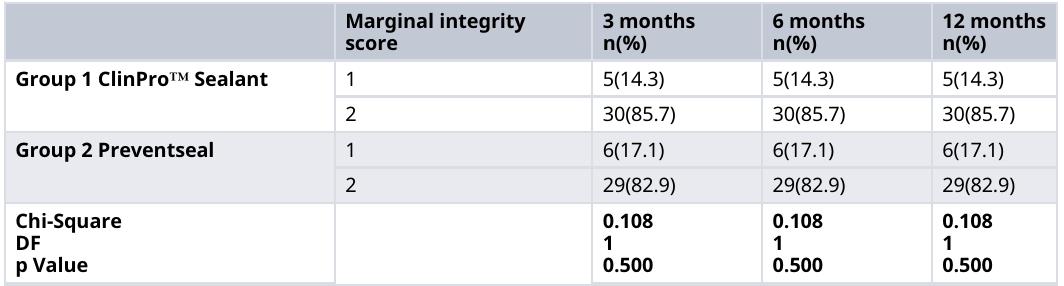
Score 1: An alteration in colour, loss of enamel translucency and defects along the enamel margins. Score 2: No changes along the enamel margin. DF: Degrees of freedom; P: